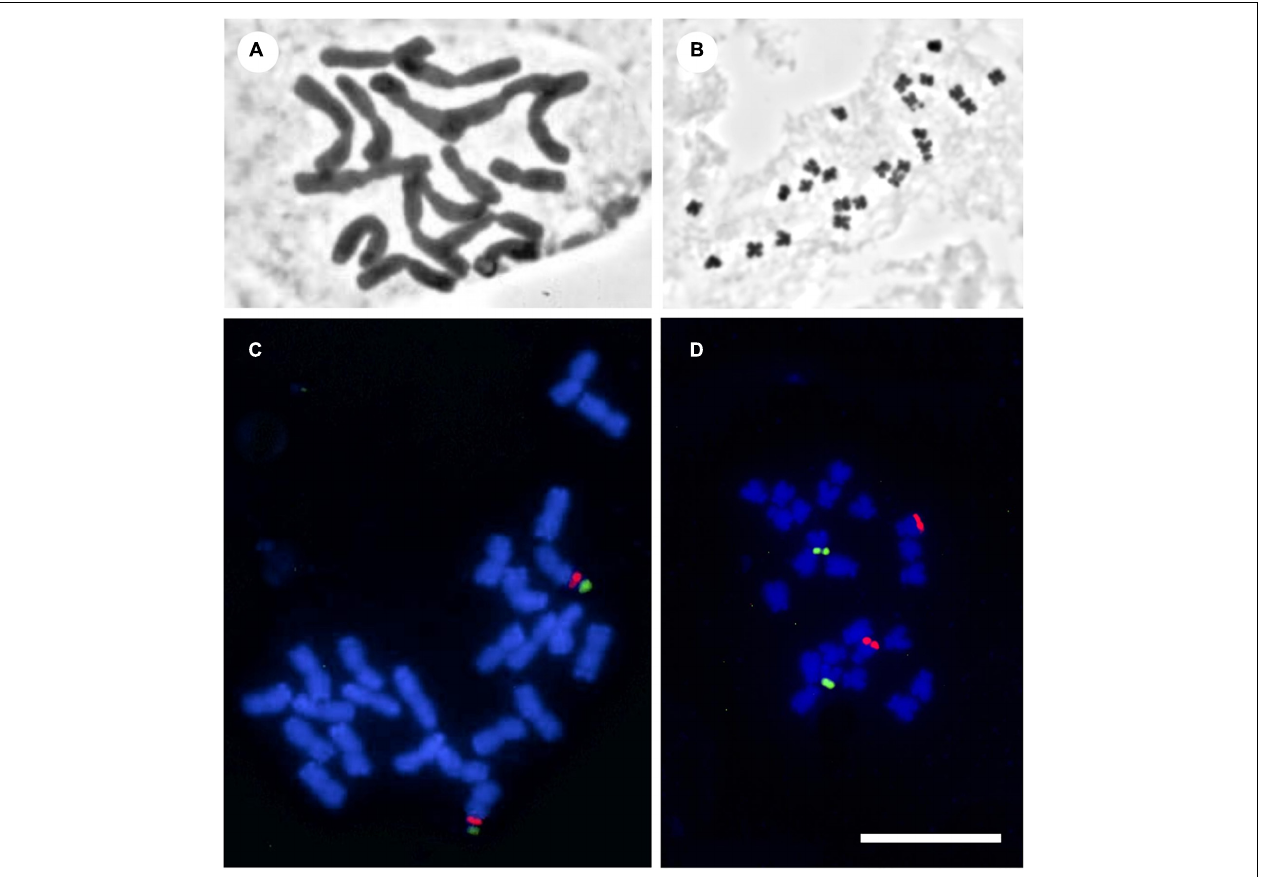
FIGURE 1 | Photomicrographs of mitotic metaphases of Solanaceae, illustrating the chromosome variety found in the family. (A) Cestrum buxifolium Kunth (2n = 16, c = 11.5 µ m, r = 1.4). (B) Solanum lidii Sunding (2n = 24, c = 1.3 µ m, r = 1.6). (C) Iochroma edule S. Leiva (2n = 24, c = 4.0, r = 1.2). (D) Physalis lagascae Roem. & Schult. (2n = 24, c = 2.5 µ m, r = 2.8). Panels (A,B) with classical staining, panels (C,D) fluorescence in situ hybridization with 5S (red) and 18-5.8-26S (green) rDNA probes. All at the same scale. Bar = 10 µ